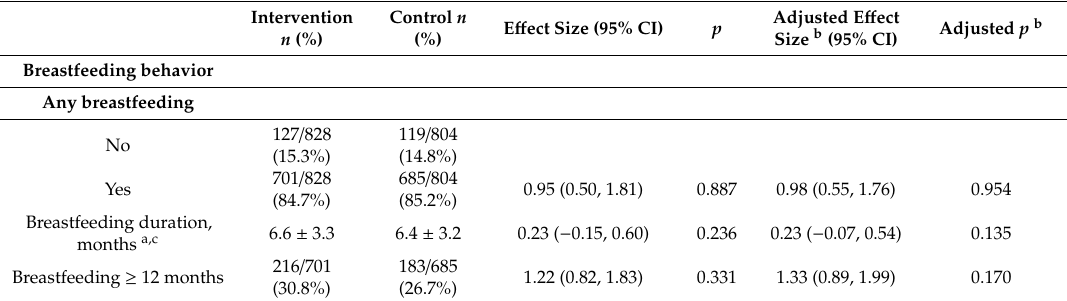
Table 3. Breastfeeding behavior of women in intervention and control